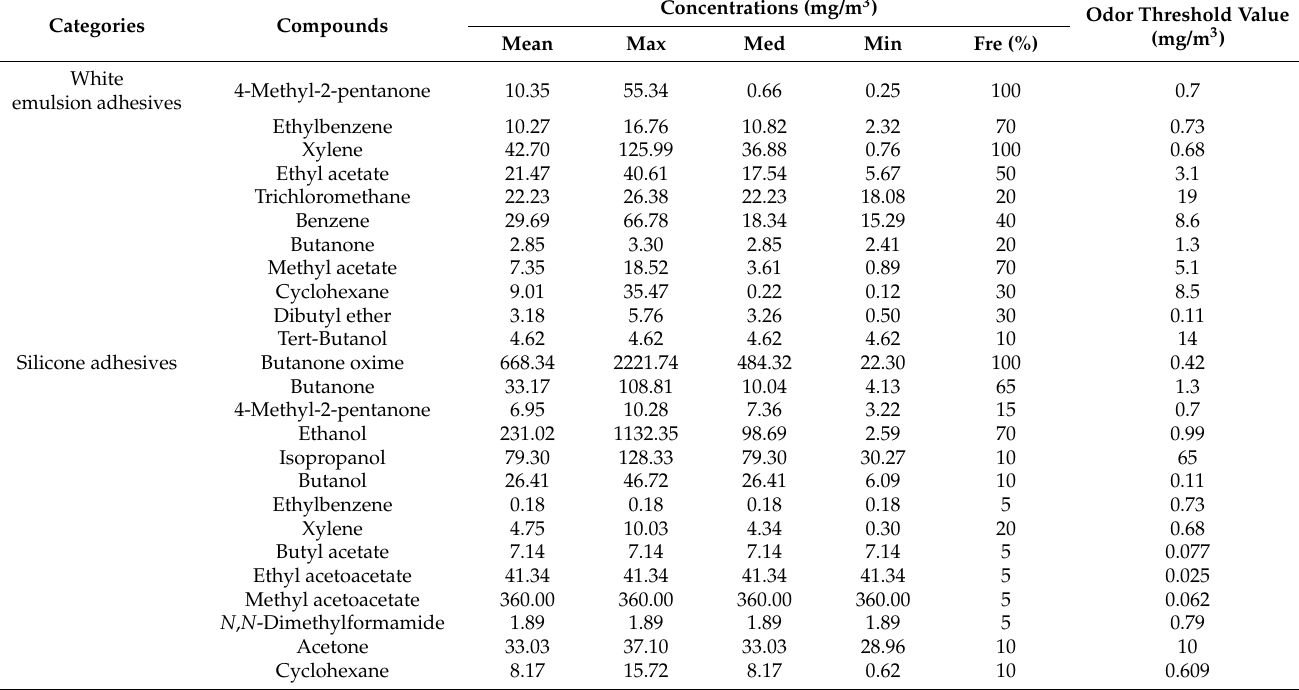
Table 1. Summary of the concentrations of compounds during VOC emission of adhesive samples (mg/m 3 ) and the corresponding odor threshold value (mg/m 3